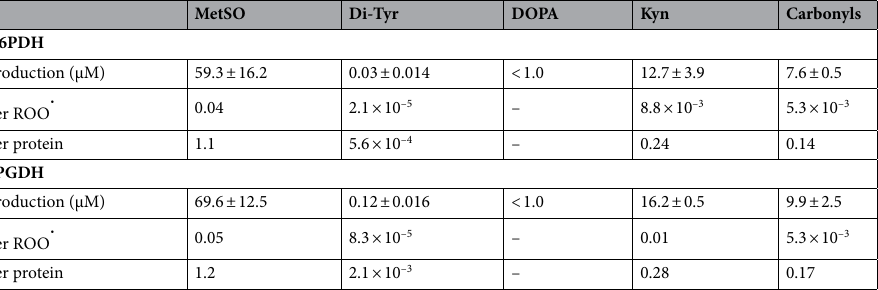
Table 2. Quantification of carbonyls and specific oxidation products of Met, Tyr, and Trp in G6PDH (54 μM) or 6PGDH (58 μM) exposed to 100 mM AAPH for 180 min at 37 °C. Total carbonyls were quantified by DNPH, while MetSO was determined in hydrolysed protein samples by HPLC with fluorescence detection and OPA precolumn derivatization. Di-tyrosine (Di-Tyr), 3,4-dihydroxyphenylalanine (DOPA) and kynurenine (Kyn) were assessed by LC–MS using selected reaction monitoring (SRM) with the following transitions: 198 → 151 for DOPA; 361 → 315 for di-Tyr; 209 → 94 for Kyn. Transitions corresponding to 237 → 118 for N -formylkynurenine, and 407 → 203 for di-tryptophan (di-Trp) were also followed, however, no signals were